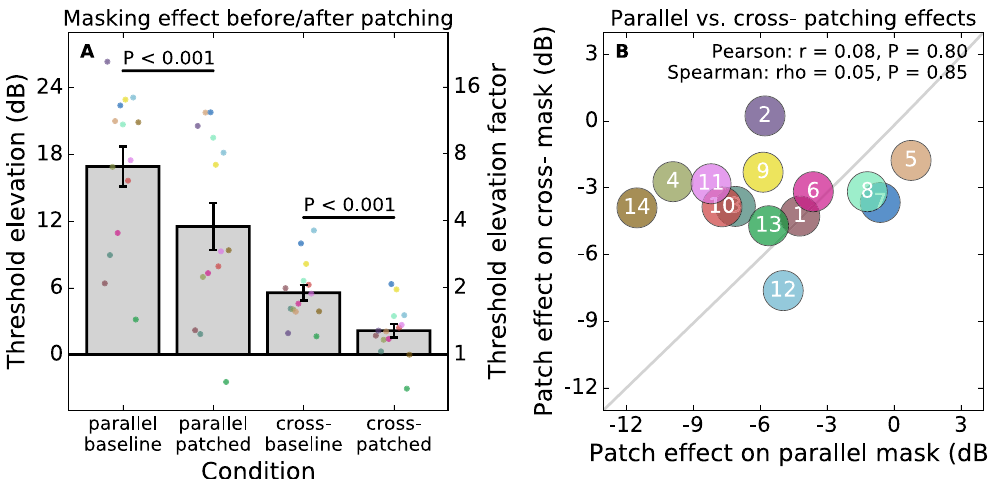
Figure 2. The effect of patching on the strength of dichoptic masking. Panel A shows the average threshold elevation from parallel and cross-oriented masks before and after patching. Coloured dots show data from individual subjects. In panel B the effects are plotted against each other for each subject, showing there to be no significant